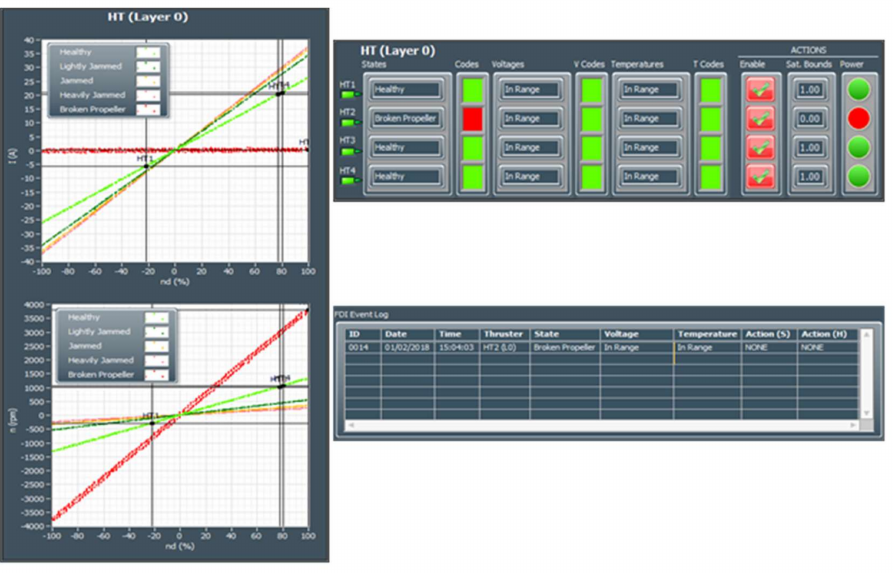
Figure 24. Test 2 (Closed-Loop): Total fault in HT2 (“Broken Propeller”) with disabled fault